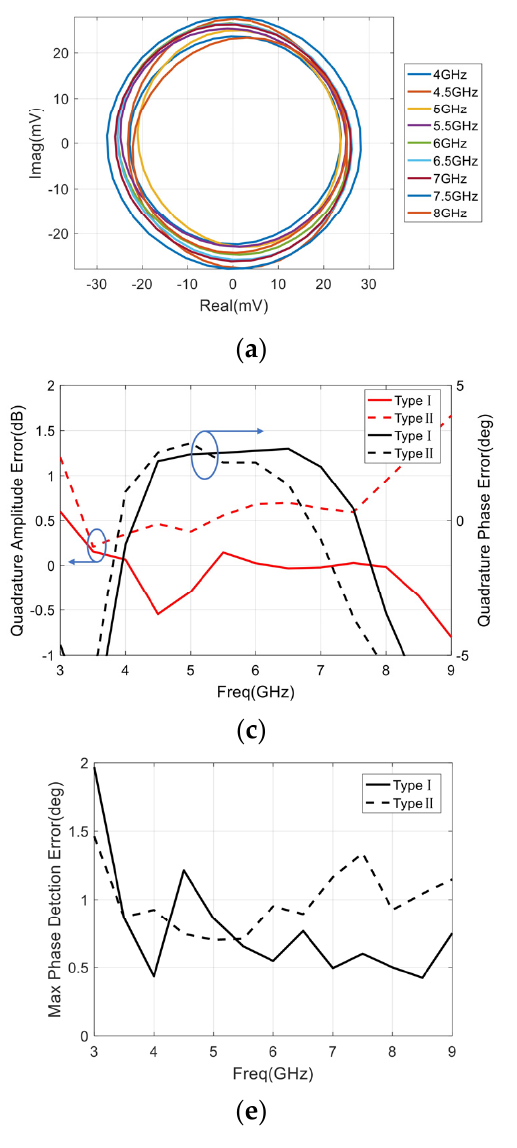
Figure 14. The measurement result of the analog correlator with frequency variation: ( a ) Correlation circle of type Ⅰ correlator; ( b ) Correlation circle of type Ⅱ correlator; ( c ) The quadrature amplitude and phase error of the correlator; ( d ) The correlation circle radius and normalized correlation amplitude of the correlator versus input power; ( e ) The maximum phase detection error versus input power; ( f ) The correlation efficiency of the correlator.